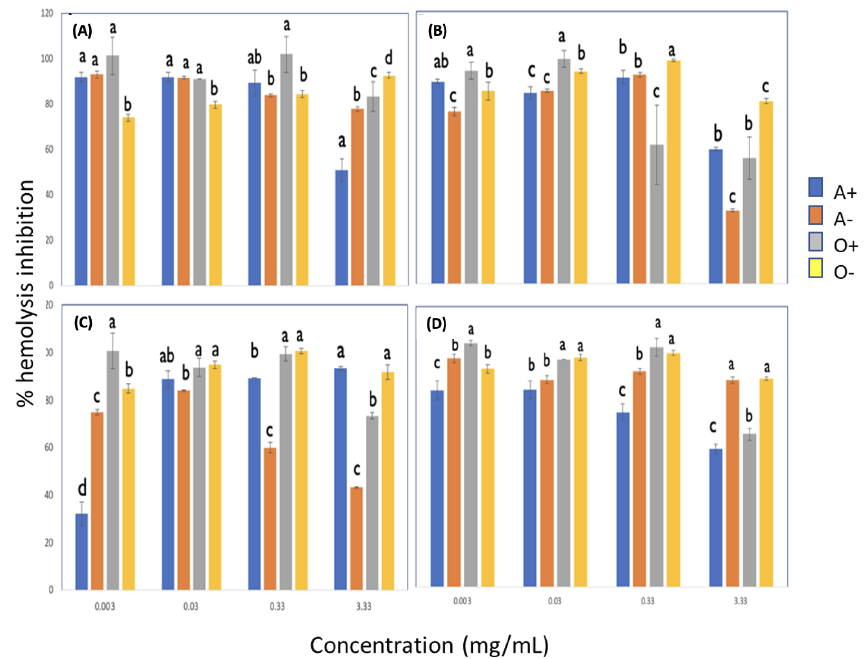
Figure 3. Effect of Rh on inhibiting free radicals induced by AAPH with lignin and without pulses. ( A ) Lignin with 0/0 time (min)/amplitude (MHz), ( B ) Lignin with 10/14 time (min)/amplitude (MHz), ( C ) Lignin with 10/18 time (min)/amplitude (MHz), ( D ) Lignin with 10/20 time (min)/amplitude (MHz). Different letters indicate significant difference ( p < 0.05).